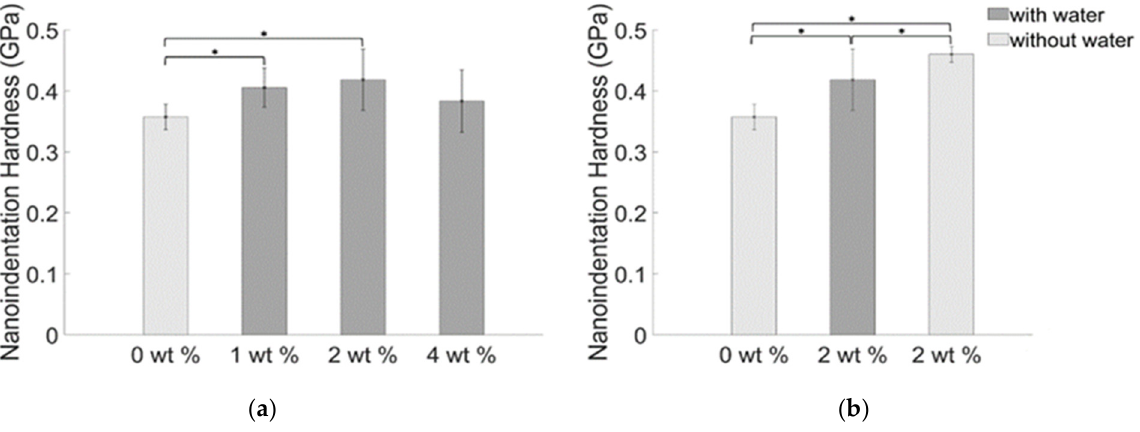
Figure 13. Average values of the nanoindentation hardness for BiONPs—composite ( a ) with water and ( b ) without water. Statistically significant differences ( p < 0.05) between cements with different filler concentration are also indicated through the asterisk.